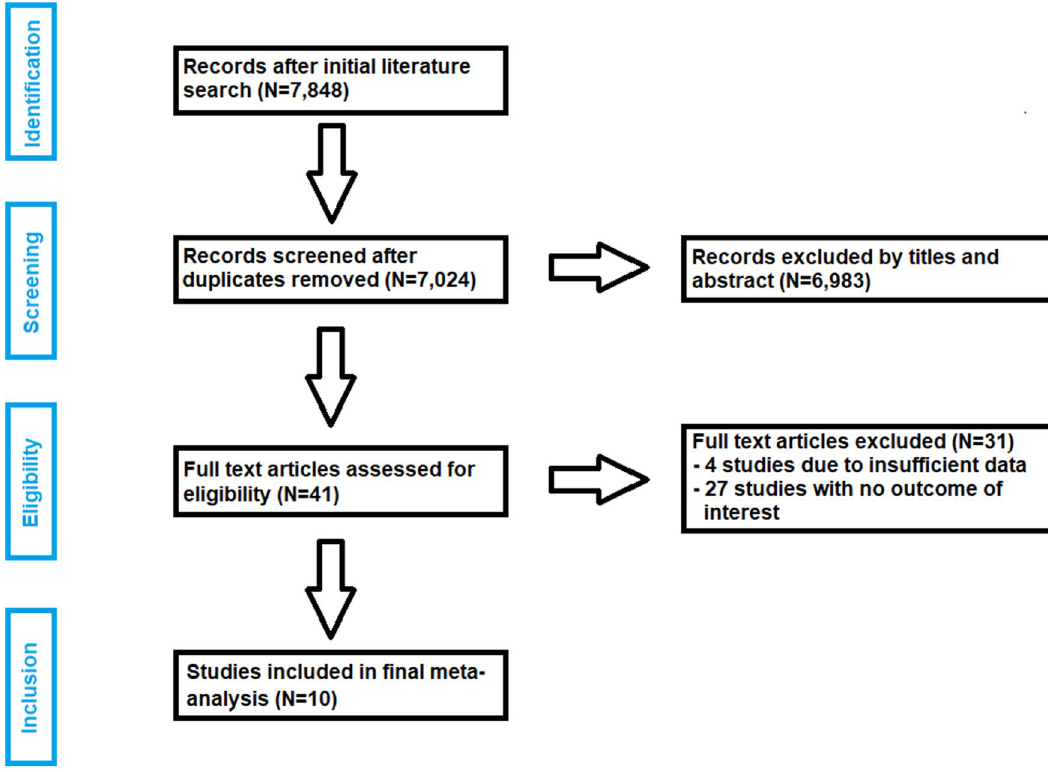
Figure 1. PRISMA flow diagram of the search results and selection according to our inclusion criteria. DAA direct anterior approach, RCTs randomized controlled